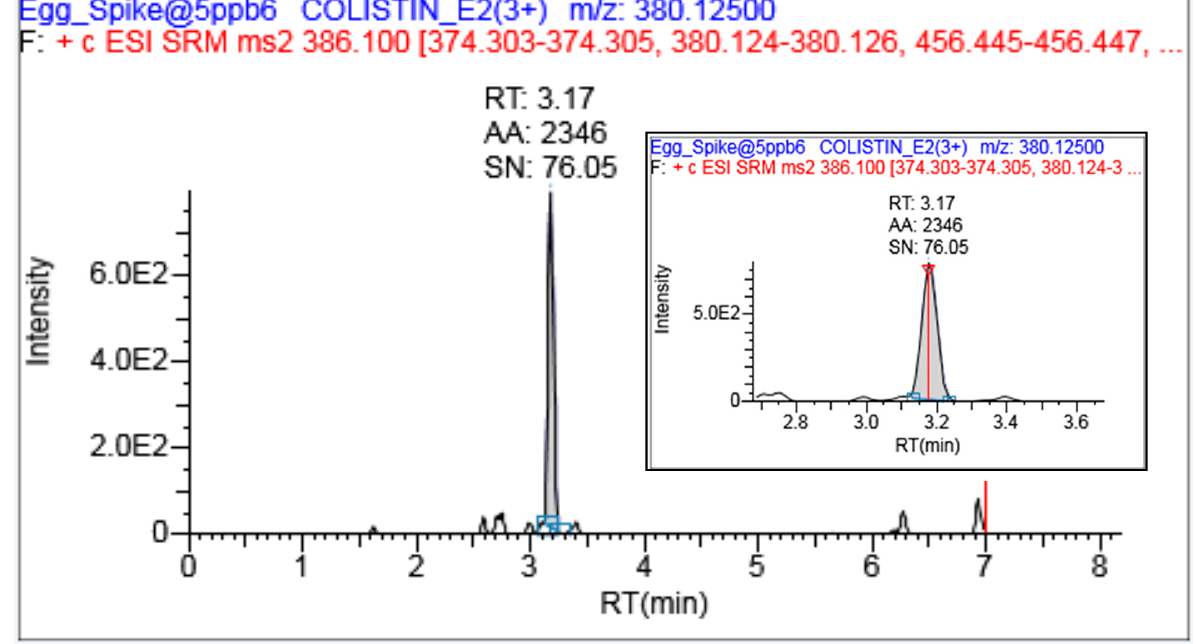
Figure 2. Representative chromatogram for colistin B under the optimized acidified mobile phase. RT: Retantion time; AA: Absolute Area; SN: Single to Nosie Ratio